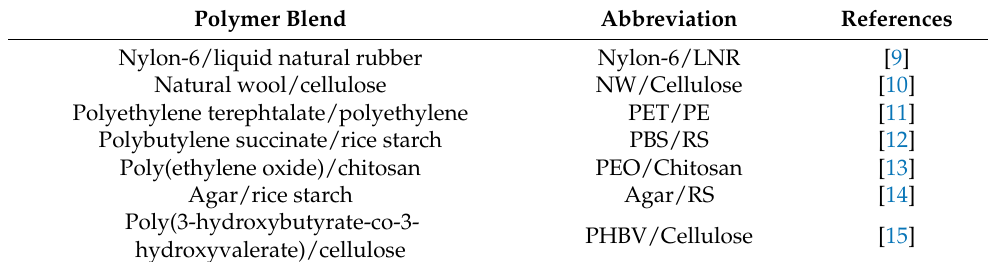
Table 1. Examples of polymer blends compatibilized by quaternary ammonium compounds (QACs).